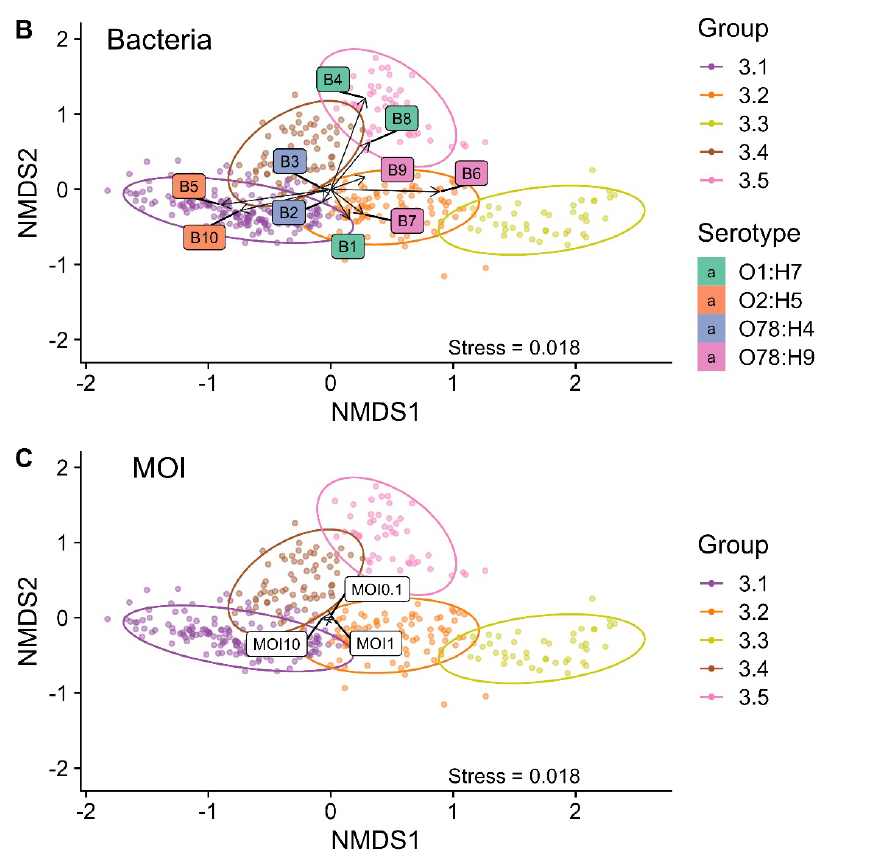
Figure 7. A nonmetric multidimensional scaling (NMDS) plot of the factors driving the Group 3 subgrouping. ( A ) Effect of the phage type. ( B ) Effect of the bacterial strain. ( C ) Effect of the multiplicity of infection (MOI). Arrows indicate the strength and direction of the correlation. Ellipses indicate a 95% confidence level based on a multivariate t-distribution. Stress < 0.02 = an okay fit.